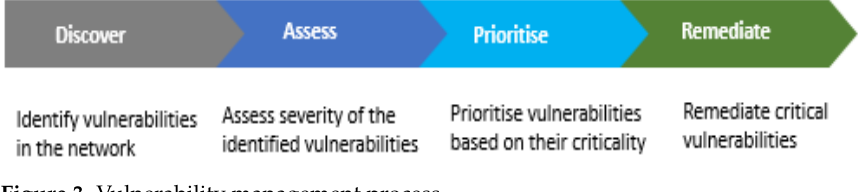
Figure 3. Vulnerability management